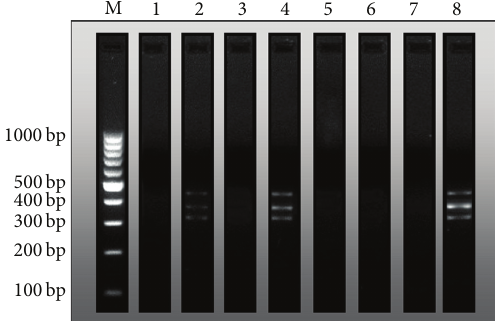
Figure 8: Determination of Muta 5/6 (361 bp), Muta 7/8 (427bp), and Muta 9/10 (313 bp) amplicons by PCR method as indices of the presence of E . coli Nissle 1917 (EcN). Representative findings in (line 1) control rats without induction of colitis and treated intragastrically (i.g.) with saline; (line 2) rats without induction of colitis and treated i.g. with Mutaflor; (line 3) rats without induction of colitis and treated i.g. with rifaximin; (line 4) rats without induction of colitis and treated i.g. with the combination of rifaximin plus Mutaflor; (line 5) rats treated i.g. with saline after induction of colitis; (line 6) rats treated i.g. with Mutaflor after induction of colitis; (line 7) rats treated i.g. with rifaximin after induction of colitis; and (line 8) rats treated i.g. with the combination of rifaximin plus Mutaflor after induction of colitis. Line M—DNA mass